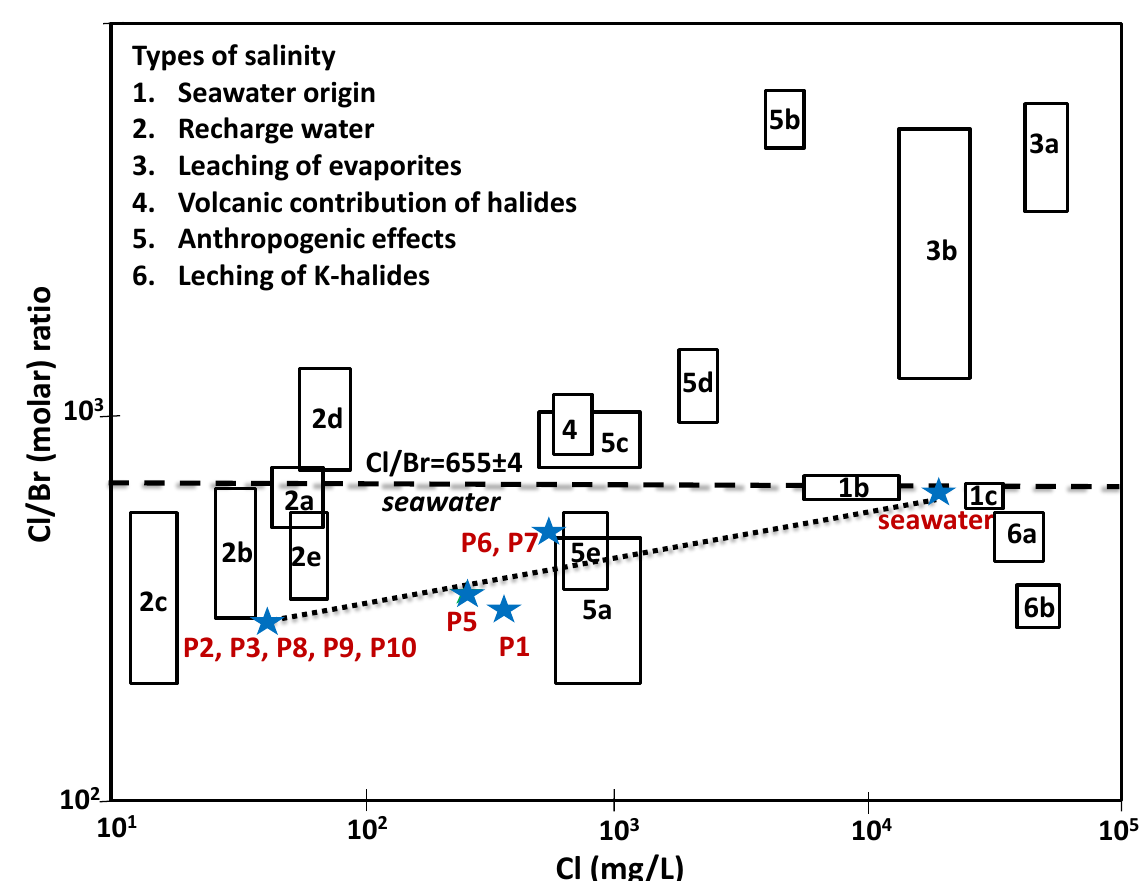
Figure 7. Cl/Br (molar) ratio versus Cl concentration of groundwater in the Ostia Antica area (Roma, central Italy) plotted over the salinity classification fields set from 24 selected aquifers of Spain and Portugal (modified from [39]). Stars stand for the average composition of well from the 2016 survey. 1b—seawater intrusion; 1c—seawater brines; 2a—recharge in coastal areas; 2b—recharge in inland areas; 2c—recharge in high altitude/continental areas; 2d—recharge in coastal